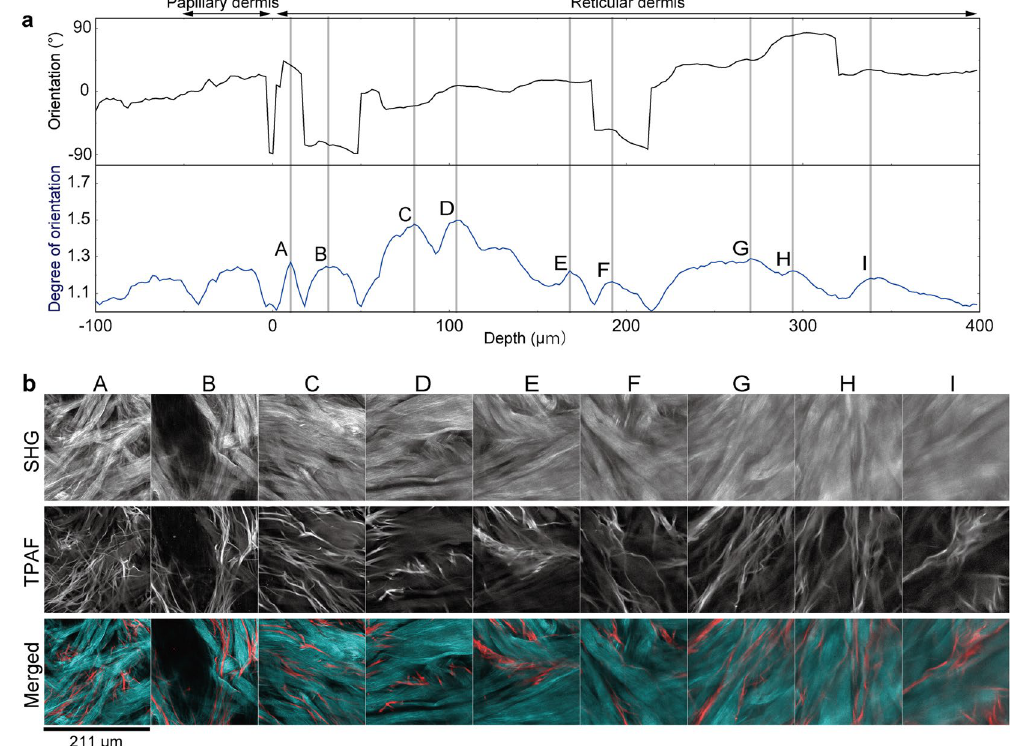
Figure 3. Identification of respective collagen fiber bundles based on peak searching. ( a ) Plot shows changes in the orientation angle (black) and the degree of orientation (blue) by depth, based on stacked second harmonic generation (SHG) images obtained in a 211 × 211 µ m area. Assuming the depth of the papillary dermis– reticular dermis boundary to be 0 and the direction from left to right in the image is equivalent to an angle of 0°, and the angle increases in the positive direction in the counter clockwise direction, A–I show representative peaks in the degree of orientation. Note the substantial change in angle between peaks A and B, E and F, and H and I. ( b ) SHG images (collagen fibers), two-photon autofluorescence (TPAF) images (elastic fibers), and merged images at depths corresponding to peaks A–I in a . Note the similarities in the direction of collagen and elastic fibers.